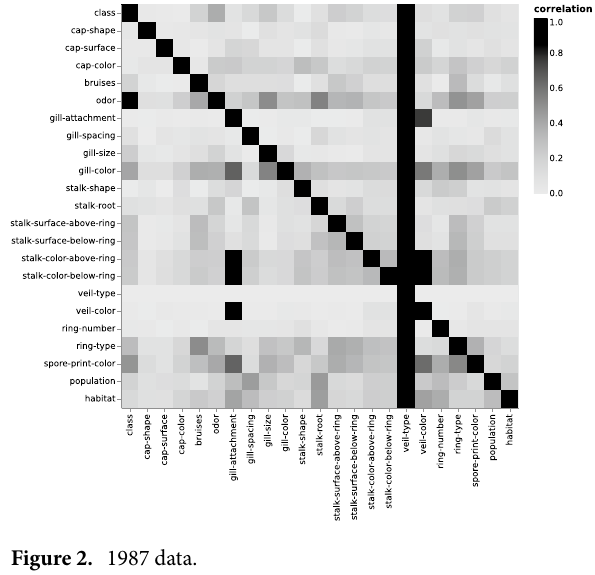
Figure 2. 1987 data.